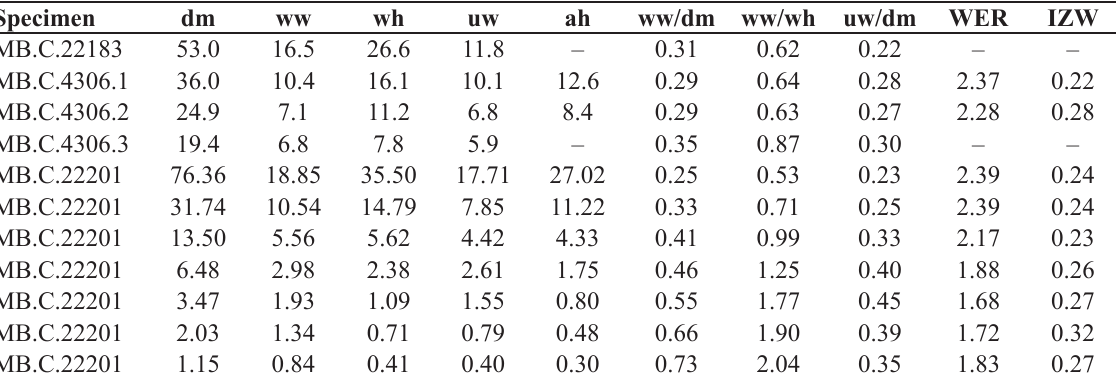
Table 7. Conch dimensions and ratios of selected specimens of Koenenites lamellosus (Sandberger & Sandberger,